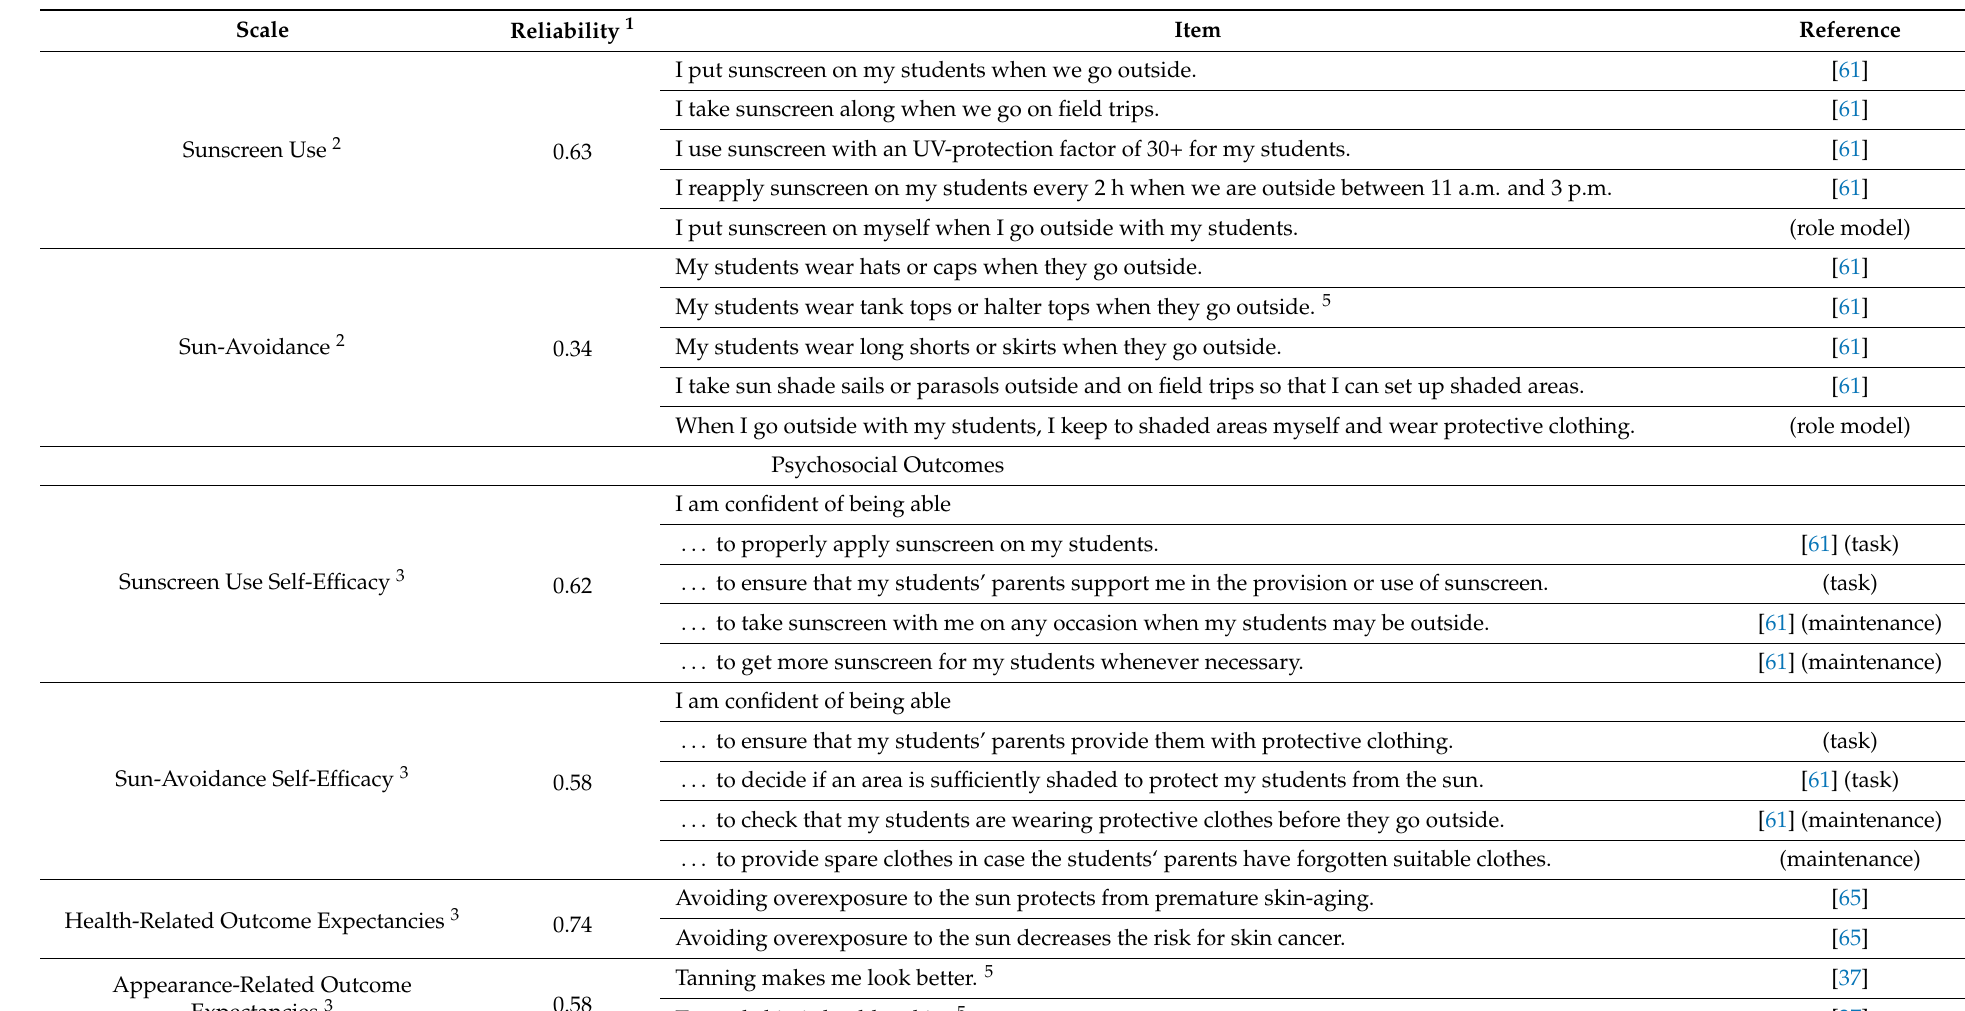
Table 3. Scales, reliability, and items of the